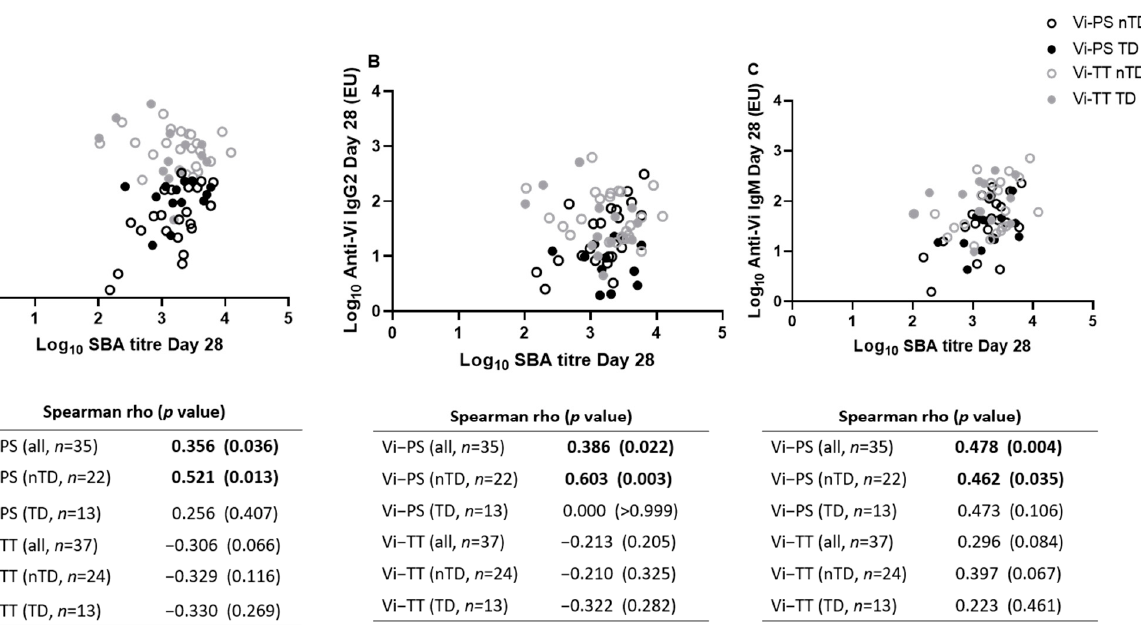
Figure 2. Correlation between anti-Vi IgG, IgG2, and IgM levels and SBA titre at the time of challenge. Correlations between SBA titre at the point of challenge with anti-Vi IgG ( A ), anti-Vi-IgG2 ( B ), and anti-Vi-IgM ( C ). TD; typhoid diagnosed, closed circles. nTD; not typhoid diagnosed/remained well, open circles.